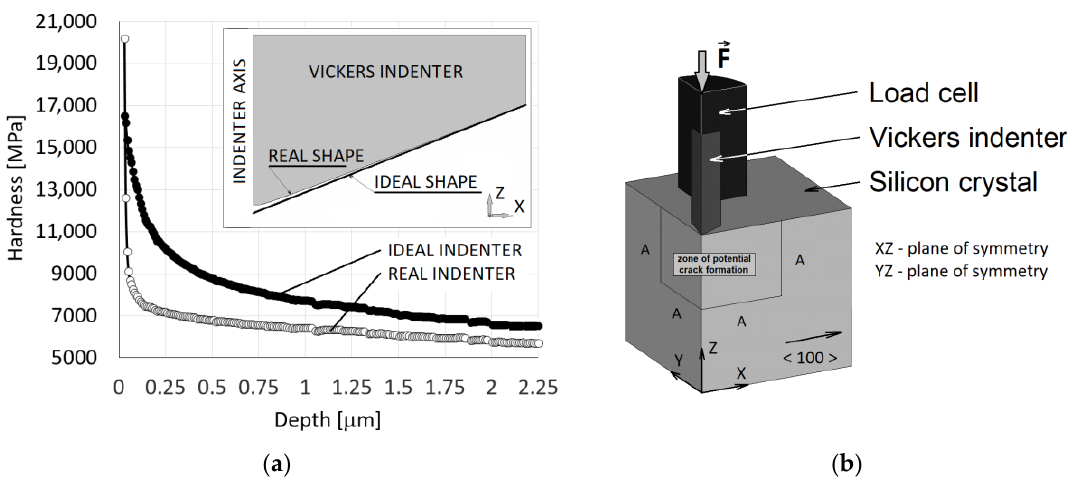
Figure 2. ( a ) FE model of Vickers indentation test on silicon crystal. ( b ) Calibration of the tip shape based on the hardness.